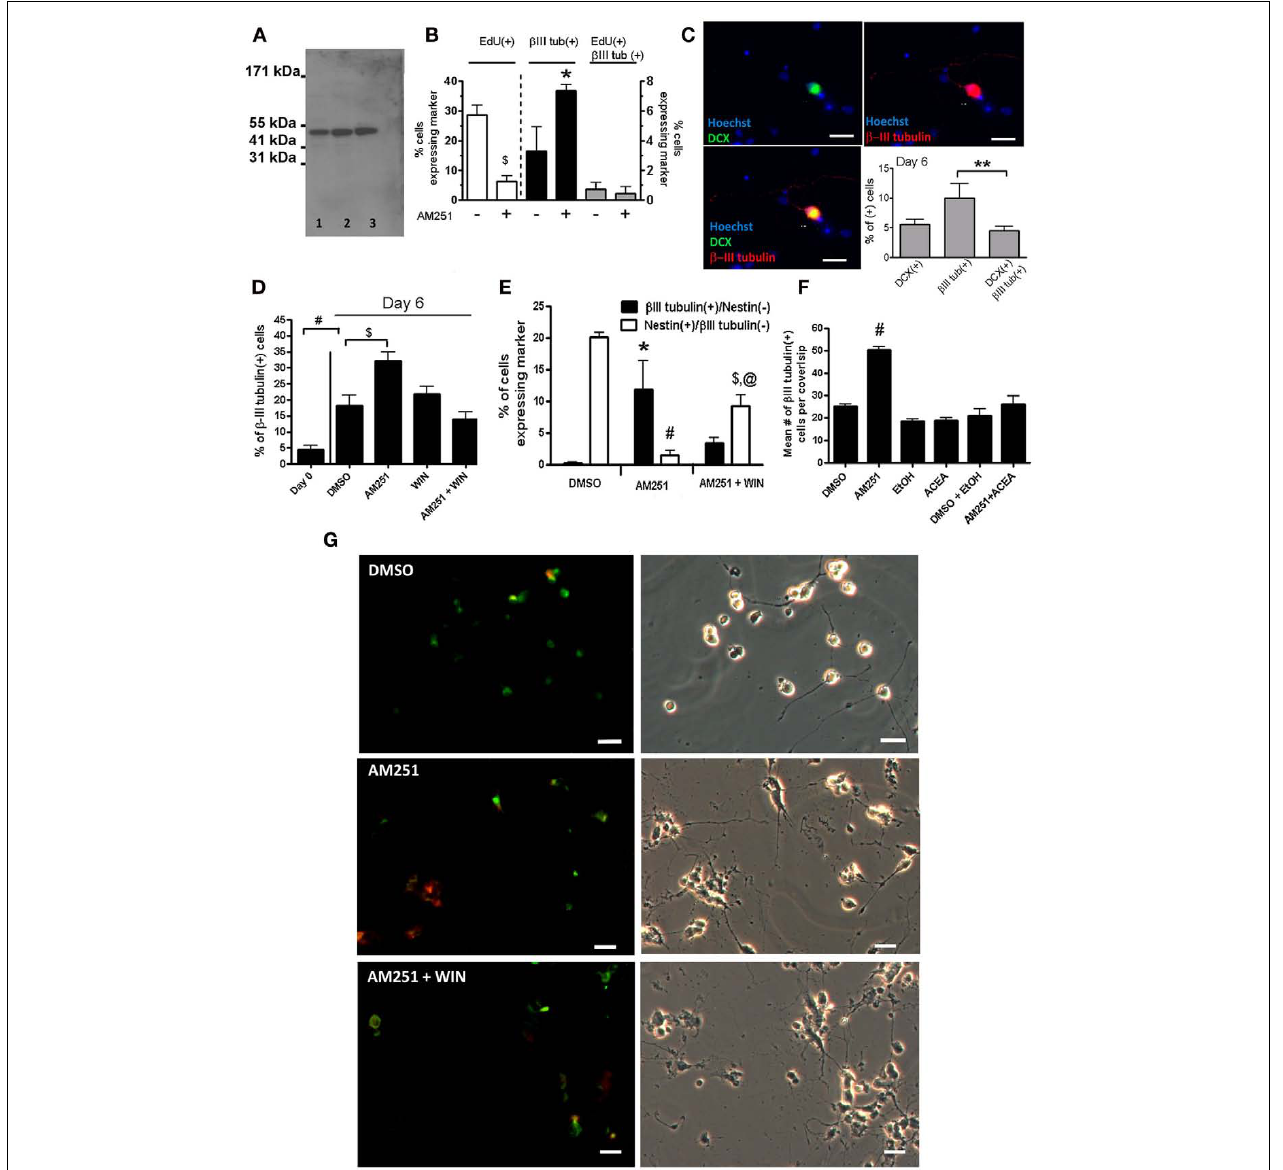
Day 6, cells were fixed and immunostained with anti- β III tubulin (black bars), and with a monoclonal Nestin antibody (white bars). Forty randomly chosen fields were analyzed per coverslip ( n = 6 coverslips from two separate experiments; exceptWIN, n = 5; mean + SEM) taken with a 20 × objective. (E) The percentage of cells expressing only β III tubulin and only Nestin at Day 6 ( n = 3 coverslips) from one of the experiments used in (D,E) . * p < 0.05; # p < 0.001, $ p < 0.01With respect to the control DMSO group at Day 6; and in (E) @ p < 0.01 with respect to the AM251 group (one-way ANOVA, Bonferroni post test). (F) In a different experiment, the number of cells expressing β III tubulin were counted in the entire coverslip treated with either vehicle 0.2% DMSO, Absolute Ethanol, 100nM AM251, or 10nM ACEA; n = 3 mean + SEM for all the groups, except for AM251 in which there were 2 coverslips; mean + range. # p < 0.001With respect to the DMSO group (one-way ANOVA, Dunnett post test). (G) Representative images of cells at Day 6 grown in either the presence of vehicle DMSO, 500nM AM251, or 500nM AM251 with 500nM ofWIN 55, 212-2. Stained with anti- β III tubulin (red), and with a polyclonal Nestin antibody (green). Scale bars = 20 μ